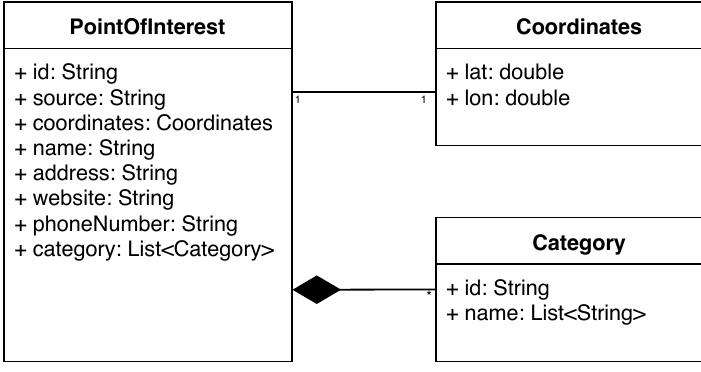
Figure 2. Unified Point of Interest model presented as a UML